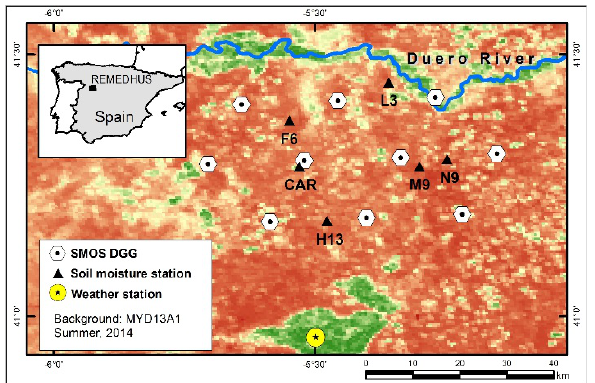
Figure 1. REMEDHUS area and some datasets included for the SMADI calculation. The image background is a MODIS-NDVI product in August,